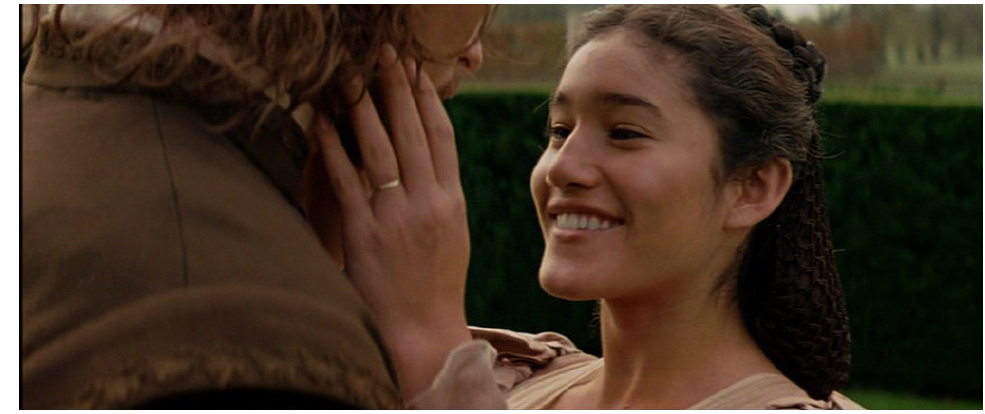
Figure 8: Pocahontas radiates her newly realised love for Rolfe in an over-the- shoulder reaction shot.